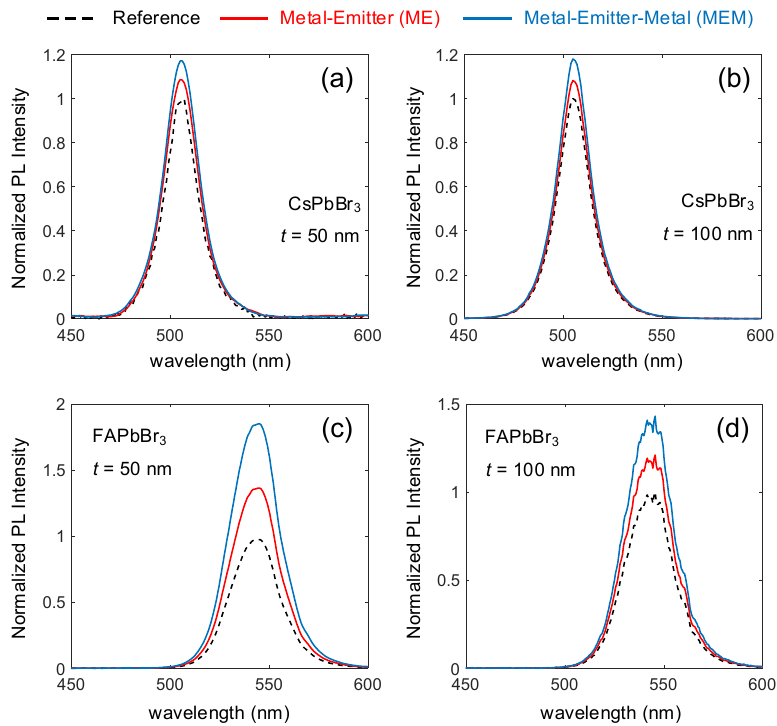
Figure 2. Photoluminescence (PL) spectra of Au-PS-NC layers at room temperature (RT) with CsPbBr 3 NCs of ( a ) 50 and ( b ) 100 nm thick; and FAPbBr 3 NCs of ( c ) 50 and ( d ) 100 nm thick. The black dashed, red solid, and blue solid lines correspond to reference, single-Au-PS, and double-Au-PS layers, respectively.